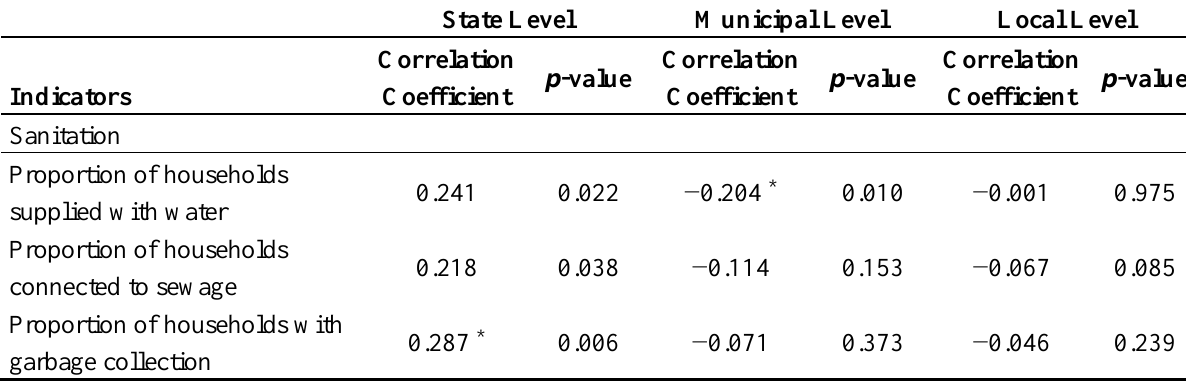
Table 2. Results of non-parametric Spearman’s rank correlation tests within the epidemic period (1996) at the three geographical